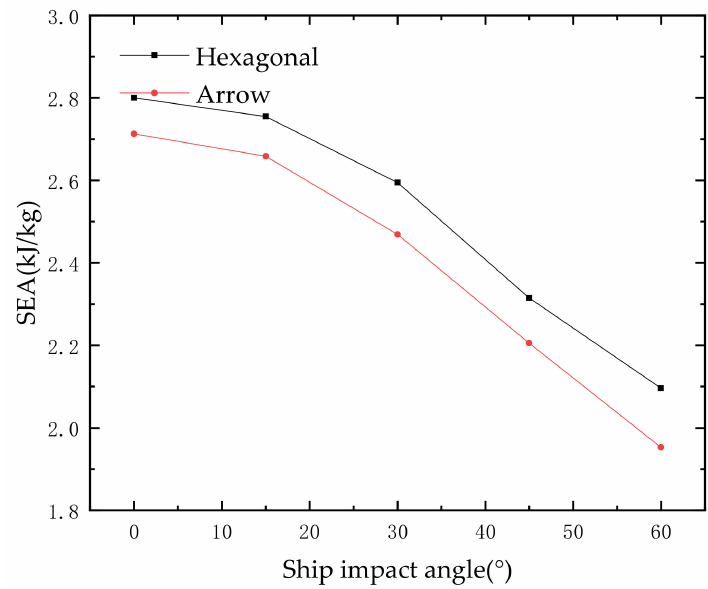
Figure 24. SEA–impact angle curve.